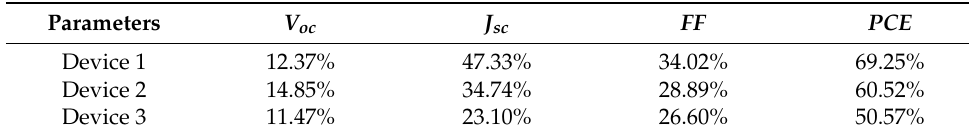
Figure 11. Effect of N t on the cell output parameters: ( a ) effect of N t on V oc , ( b ) effect of N t on J sc , ( c ) effect of N t on FF , and ( d ) effect of N t on PCE . Table 3. Decreases of output parameters.